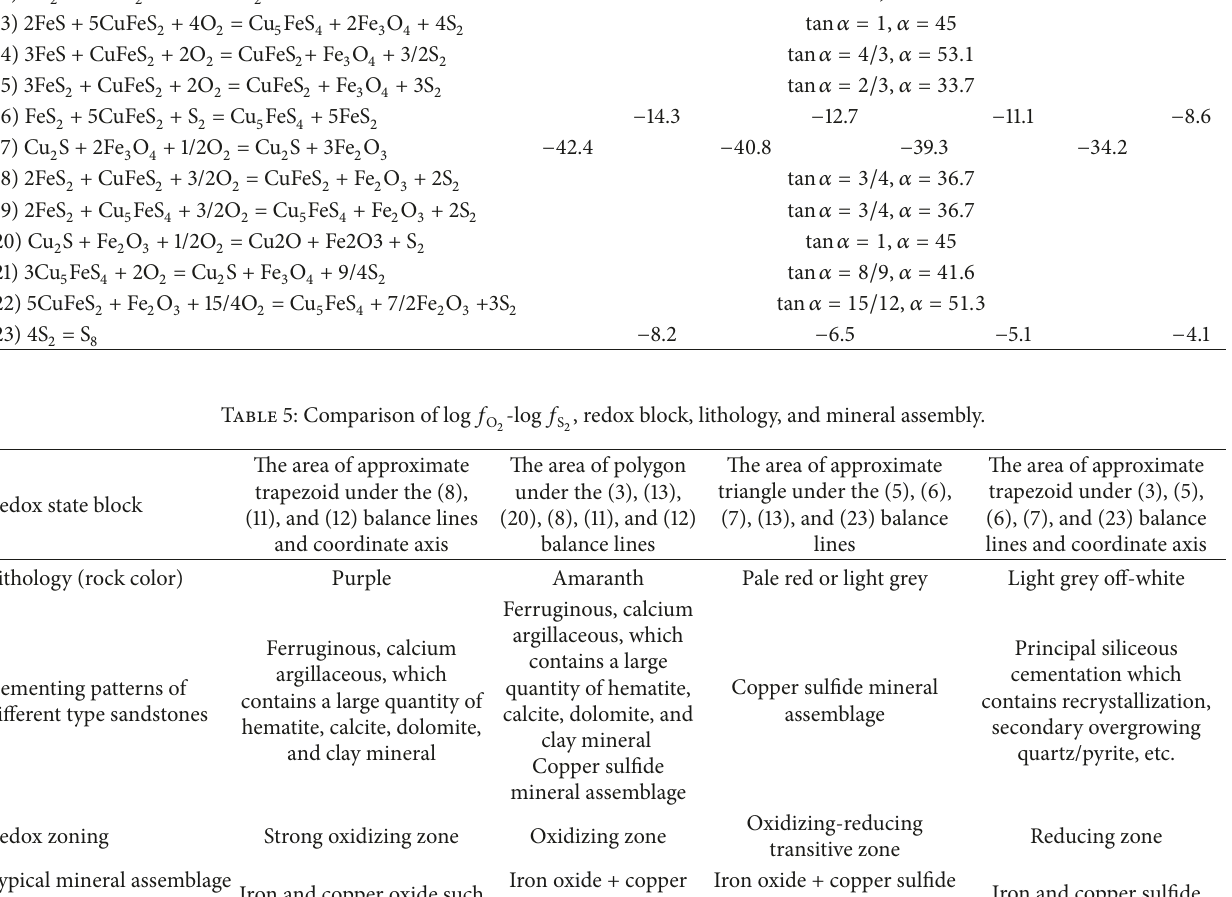
Table 4: Chemical reactions and log 𝑓